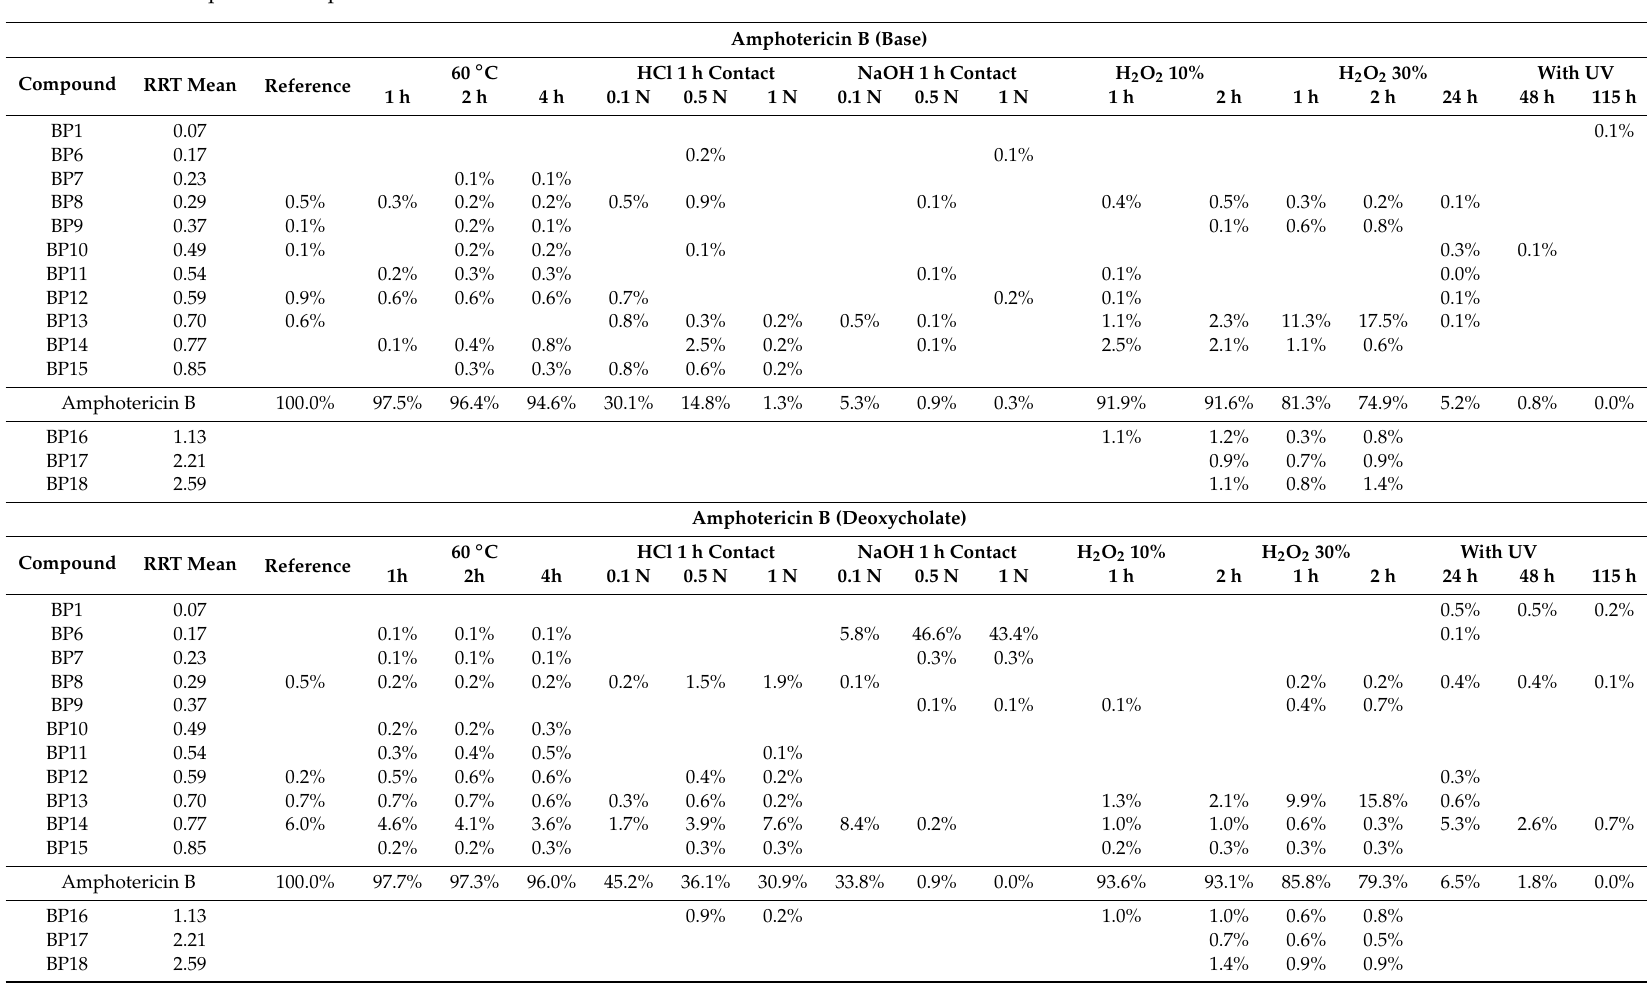
Table 1. Amphotericin B forced degradation results for di ff erent conditions, in % of reference amphotericin B peak area. BP: Breakdown product. RRT: relative retention time compared to amphotericin B retention